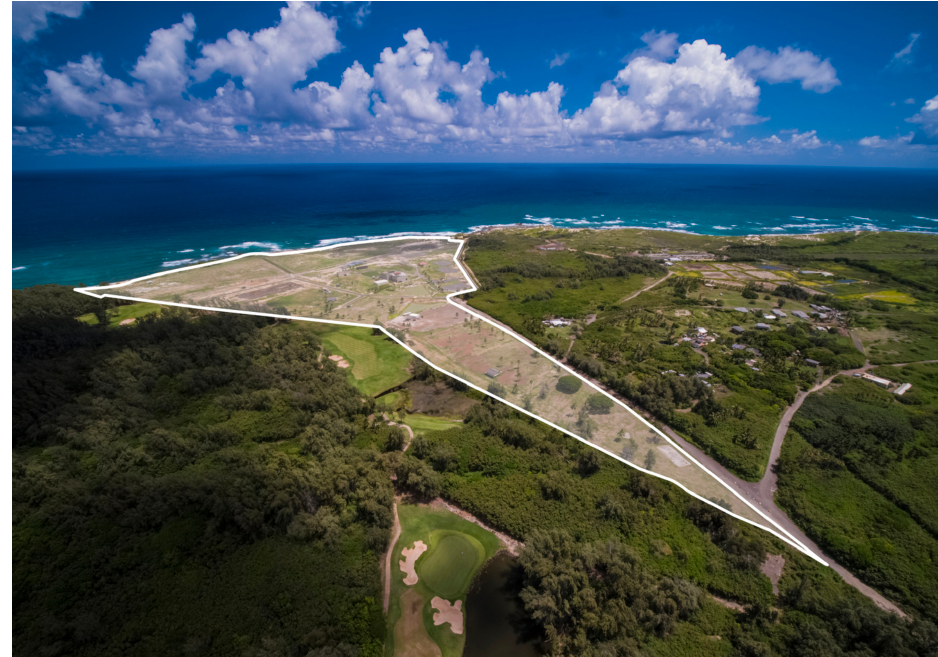
Figure 2.1: Promotional images of Marconi Farms housing development, Kahuku, O‘ahu, Hawai‘i. Author’s screen